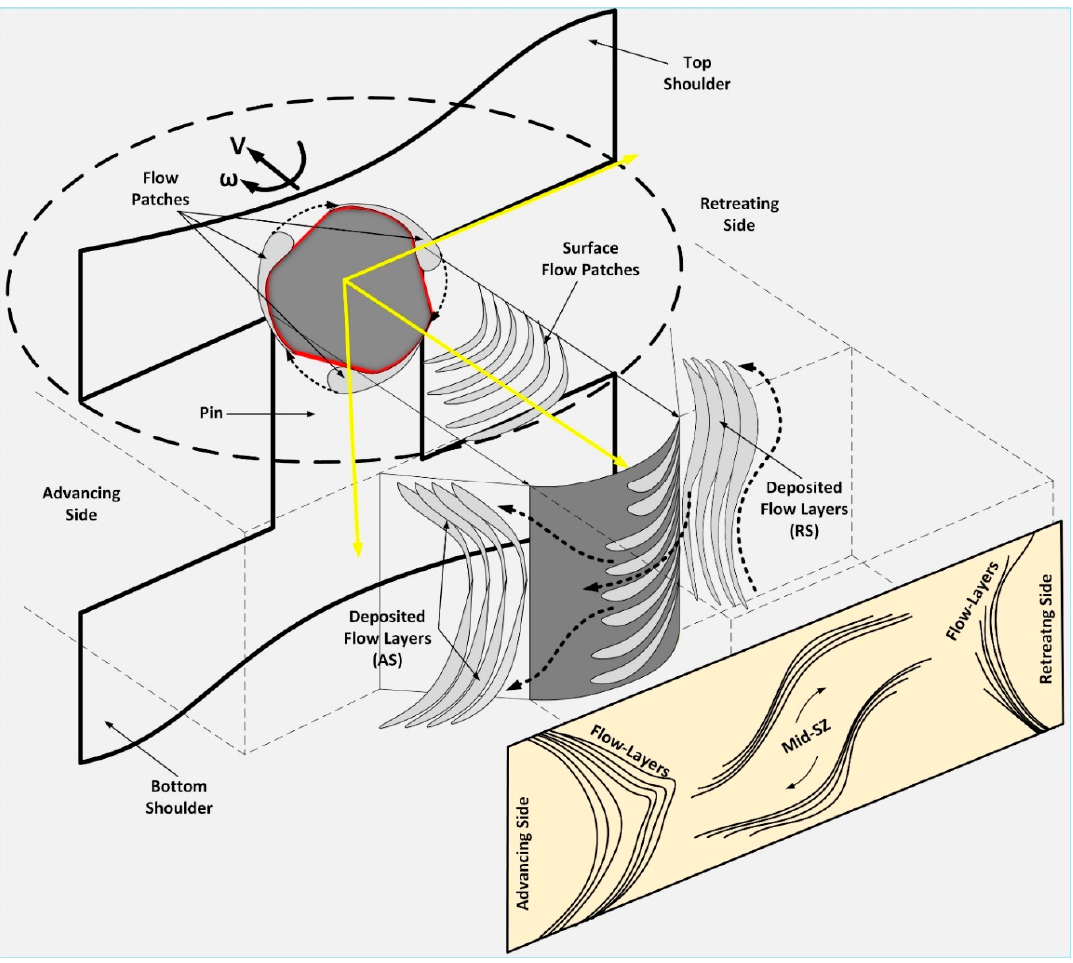
Figure 15. Schematic of the cross-section of the weld with a proposed model for the formation mechanism of the flow-arms at the breadth of the stirring zone, between the AS and RS.